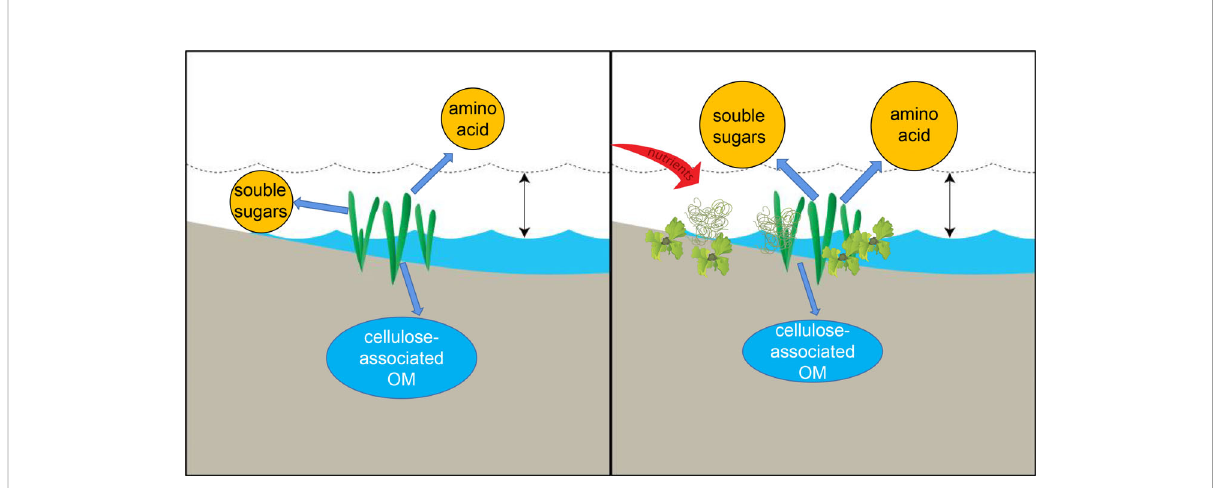
FIGURE 7 Impact of eutrophication on seagrass meadow. The dashed wave line and blue wave line represents high tide and low tide,